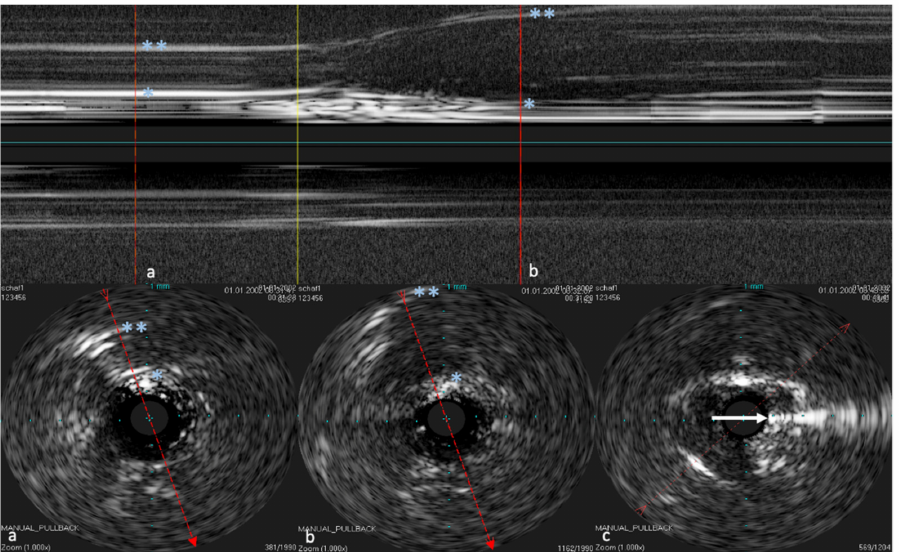
Figure 6. Sonographic image of the injection of HA into the tissue. The probe remained stationary during this procedure. The upper image shows the temporal course of the procedure over approx- imately 20 s. Image ( a ) is the cross-section of the ET before the injection and image ( b ) during the injection. The yellow line marks the start time of the injection. During the course, how the echogenic tissue layers (marked by the * and **) pressed apart due to the injected echo-poor HA is visible. Image ( c ) shows the cannula (marked by the white arrow) in the sonographic image. Note that image ( c ) is not from the longitudinal view shown above.